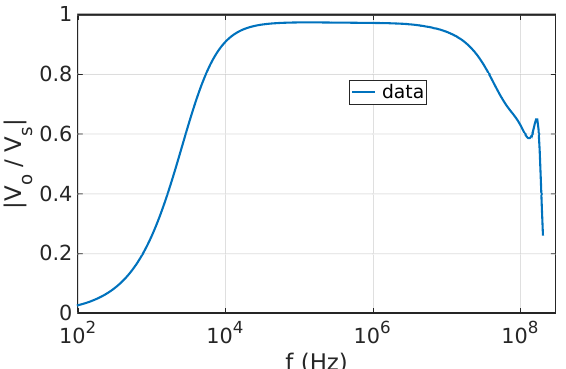
Figure 4. Transfer function (the ratio between the output and the input in frequency domain) of the selected transformer, Würth Elektronik